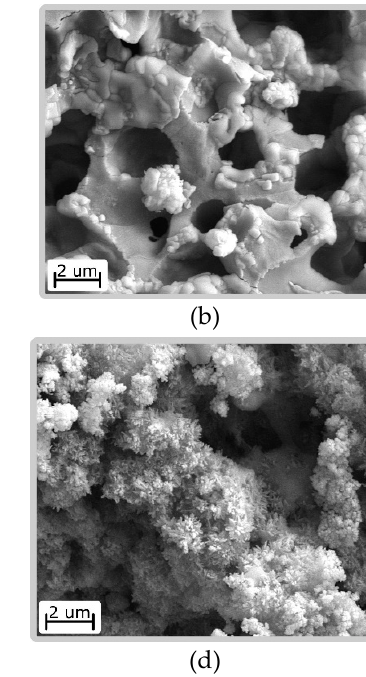
Figure 5. SEM images of samples prepared in atmosphere of NH 3 : ( a ) chitosan film; ( b ) chi- tosan/phosphate film dried at 100 °C; ( c ) composite produced from chitosan/phosphate film in 0.1 M NaOH during 5 days at 25 °C; ( d ) composite produced from chitosan/phosphate film in 0.1 M NaOH during 12 h at 100 °C.